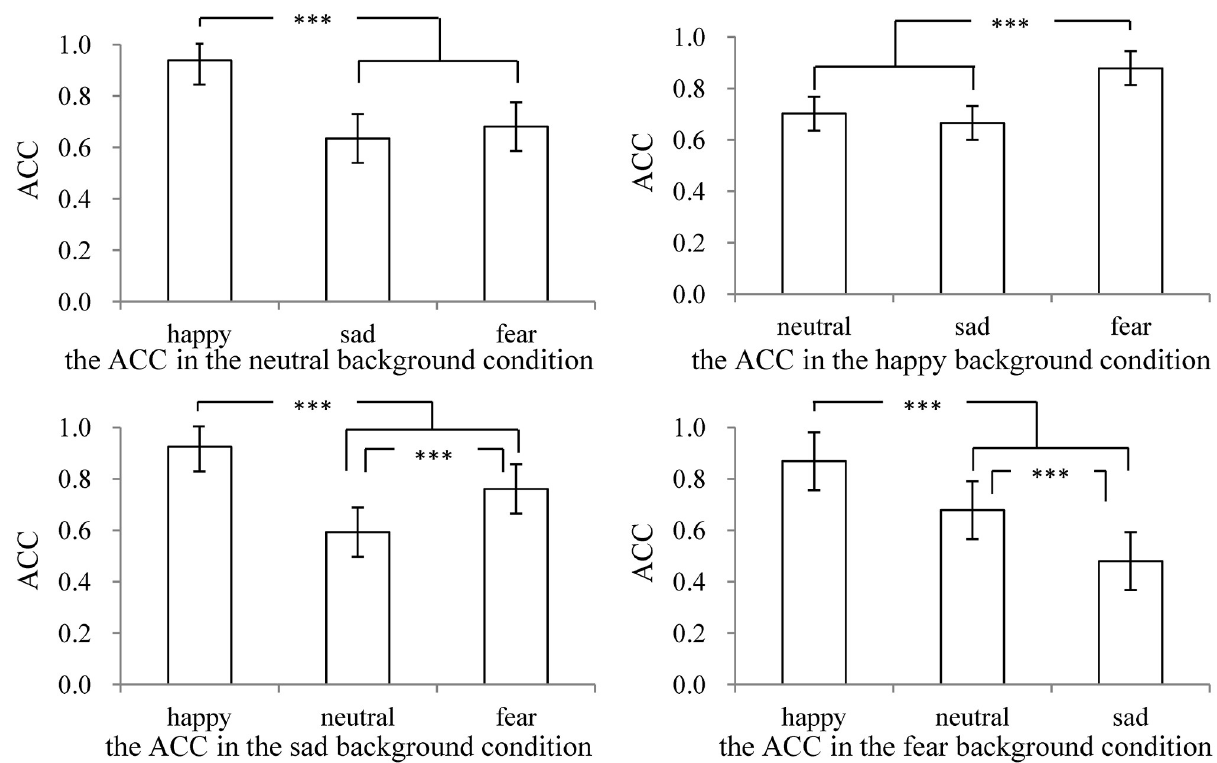
Fig 2. The ACC of recognizing different MEs in different background conditions. “ ��� ”stands for “ p < 0.001”. Error bar represents standard errors.